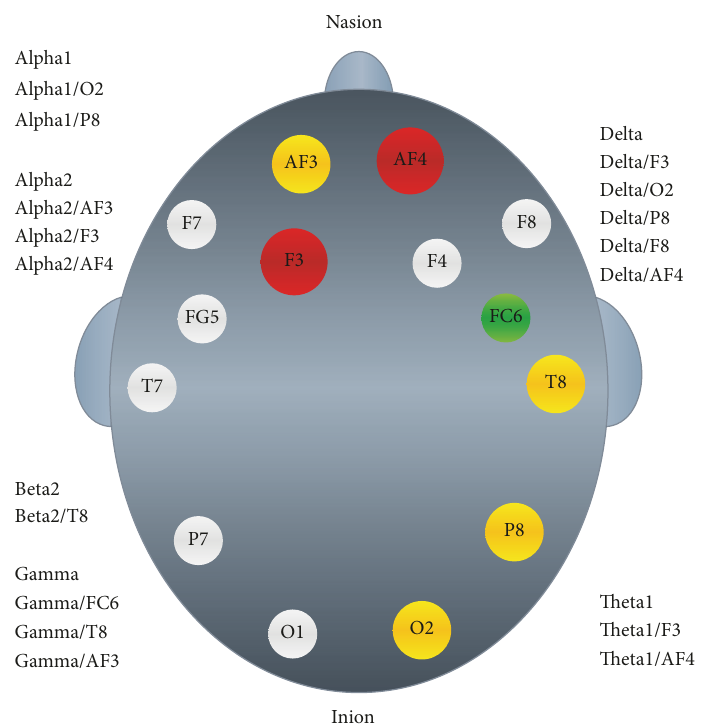
Figure 7: EEG oscillations based on the EMOTIV Epoc EEG apparatus; coloured sites indicate significant group